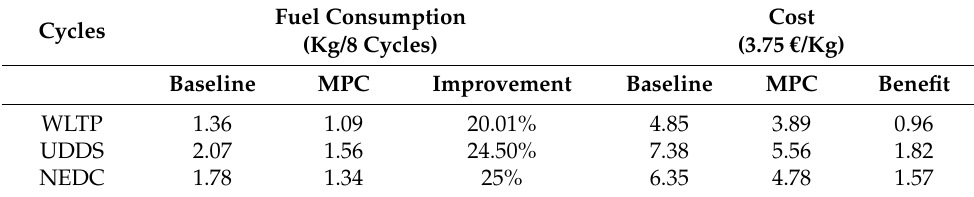
Table 1. Performance